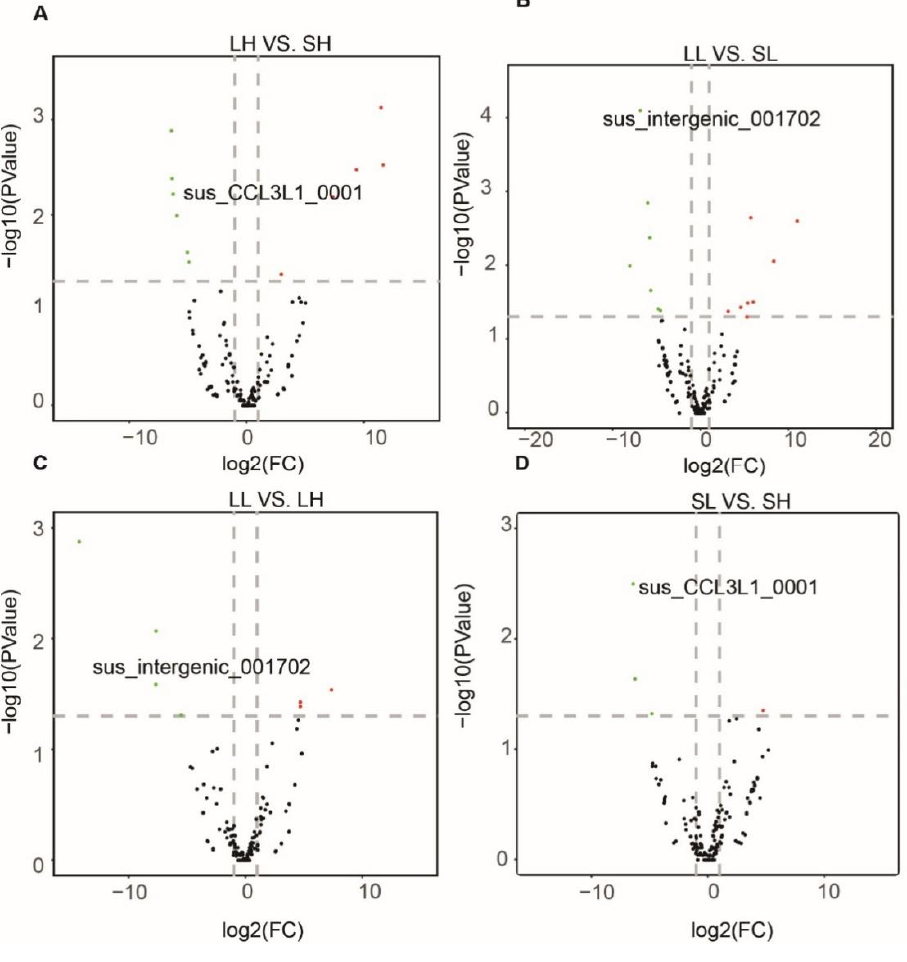
Figure 3. The DECs between and within breeds. ( A ) Significant DECs between LH and SH. ( B ) Significant DECs between LL and SL. ( C ) Significant DECs between low and high backfat of Landrace pigs. ( D ) Significantly DECs between low and high backfat of Songliao black pigs.